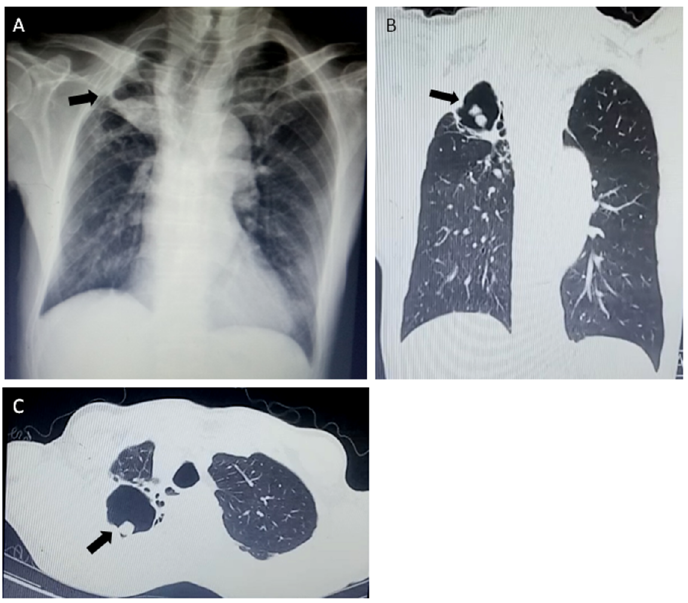
Figure 2. Radiological findings of chronic pulmonary aspergillosis (CPA) in a 51-year-old male patient two months after completion of TB treatment. A large cavity with aspergilloma (black arrows) of the left upper lobe in chest X-ray ( A ) and computed tomography scans ( B , C ).